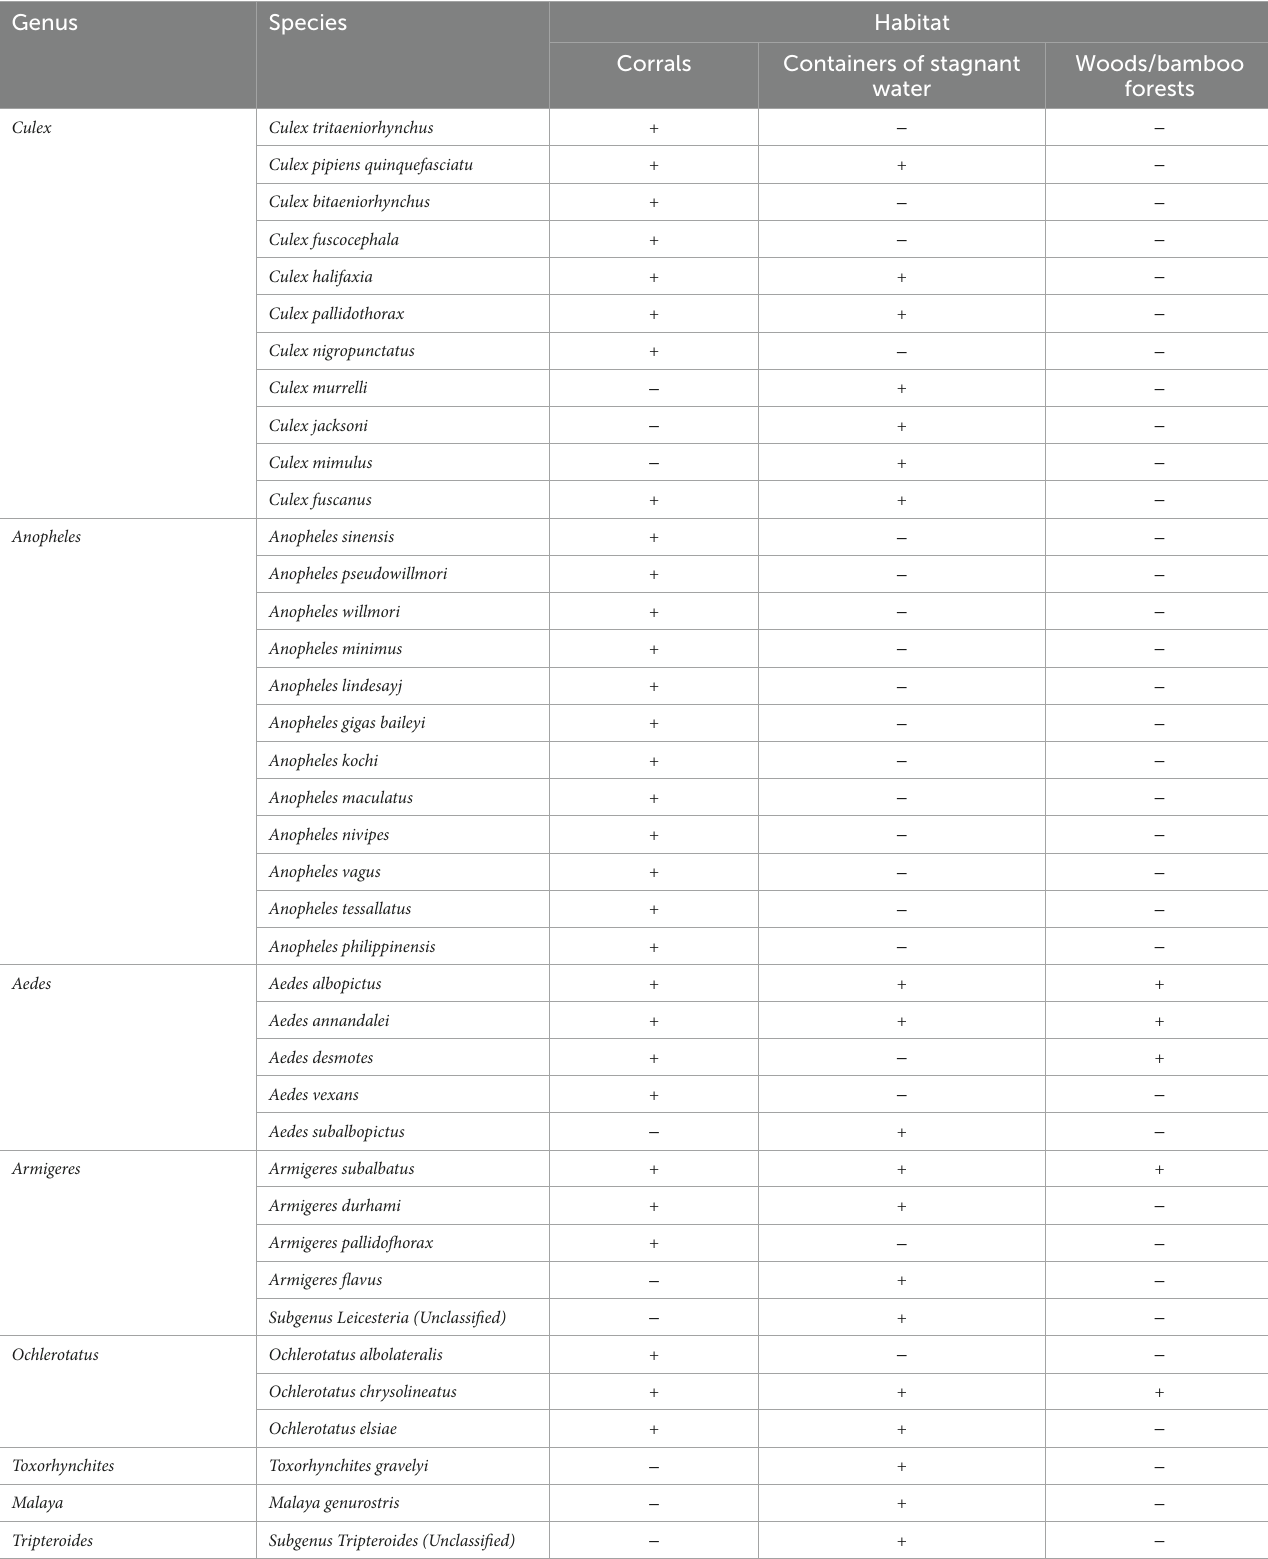
TABLE 1 Mosquito species collected in different habitats.